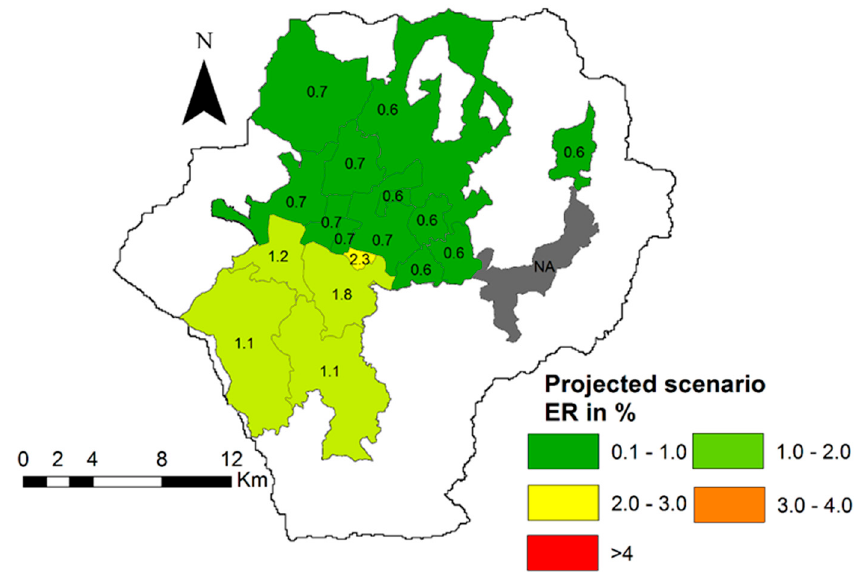
Figure 7. Expenditure ratio in % at minimum water use = 80 LPCD, water price = NRs.24/CuM.